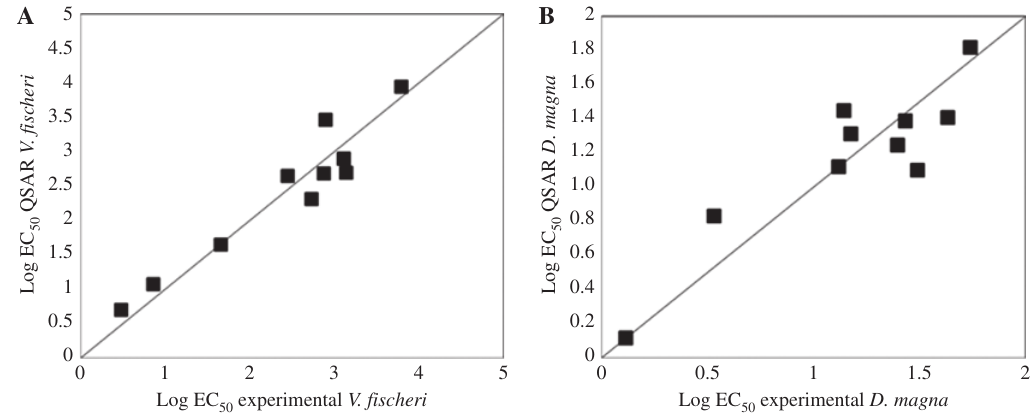
as calculated through multiregression analysis in Vibrio fischeri (A) and 50